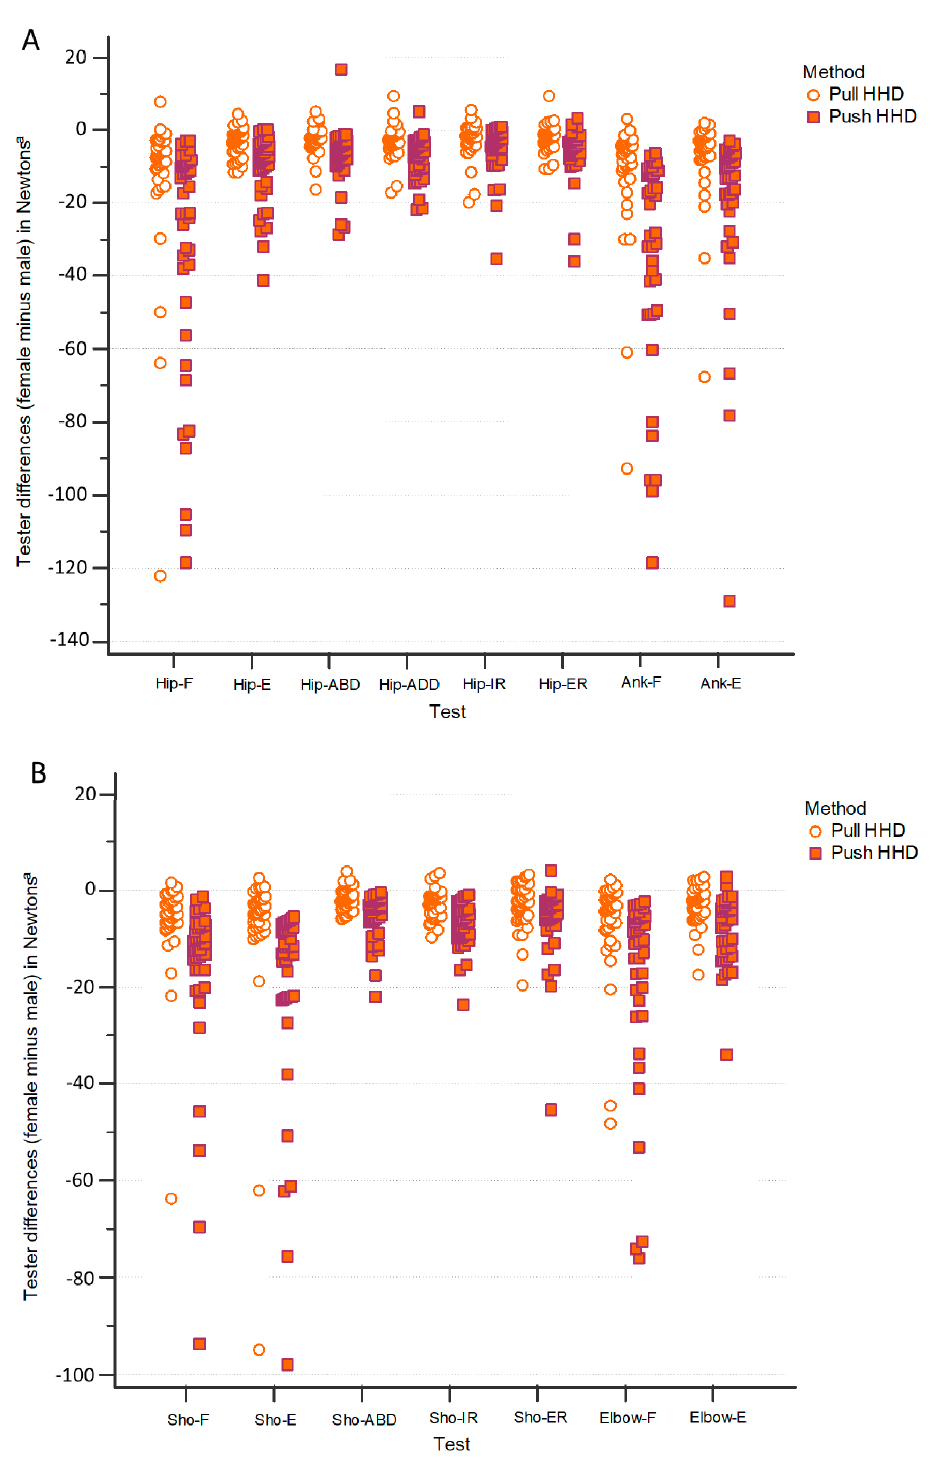
Figure 2. Differences between raters in the lower limb ( A ) and in the upper limb ( B ) for the strength measurements in each participant by test and method. Table 4. Inter-rater reliability and agreement for the push HHD method by movement.